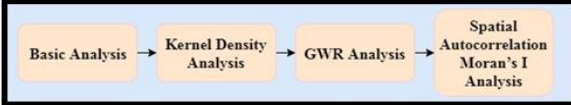
Figure 5. Sequence of spatial analysis